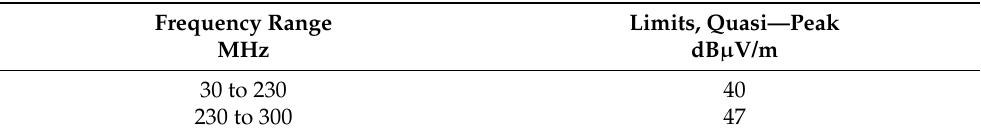
Table 1. Radiated disturbance limits in the frequency range 30 to 300 MHz for a measurement distance of 3 m for the SAC method.